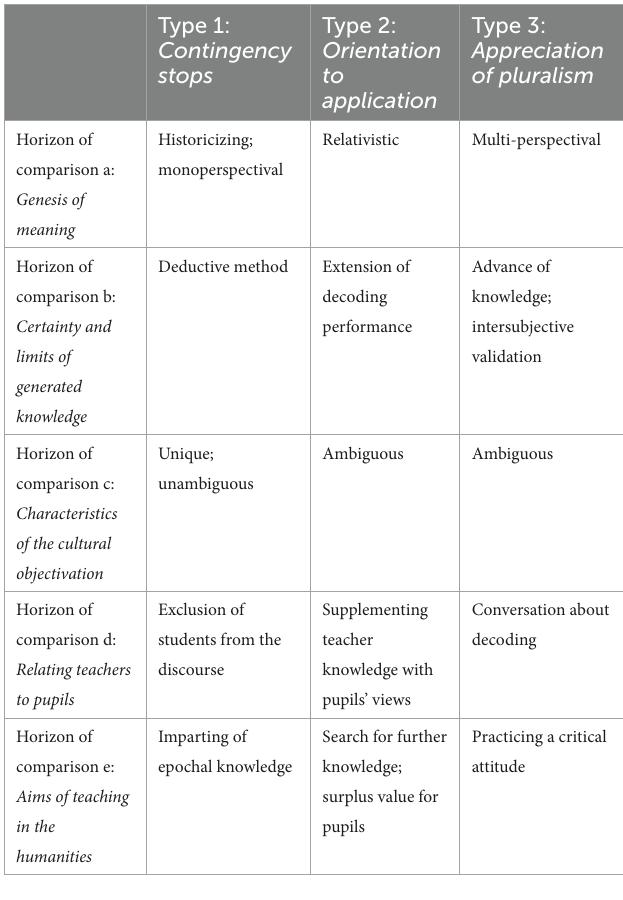
TABLE 1 Qualitative typology obtained from documentary